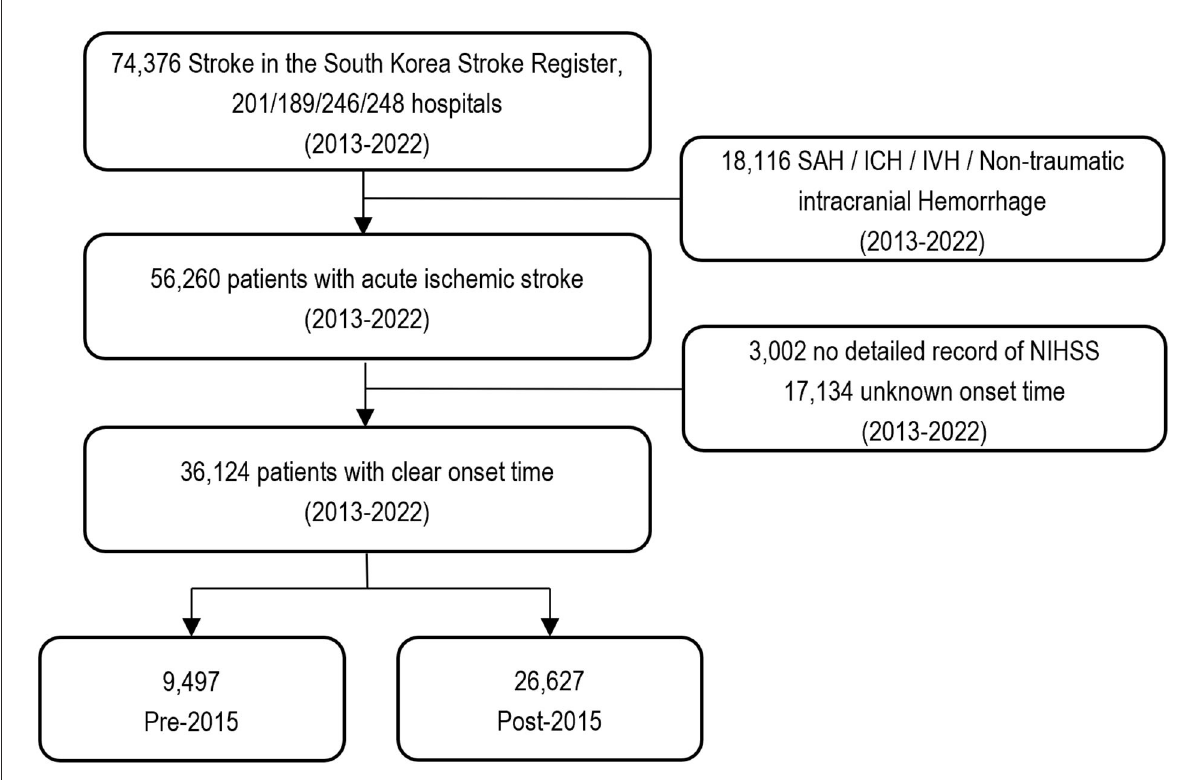
FIGURE1 A flow chart of study population. NIHSS, National Institutes of Health Stroke Scale; SAH, subarachnoid hemorrhage; ICH, intracerebral hemorrhage; IVH, intraventricular